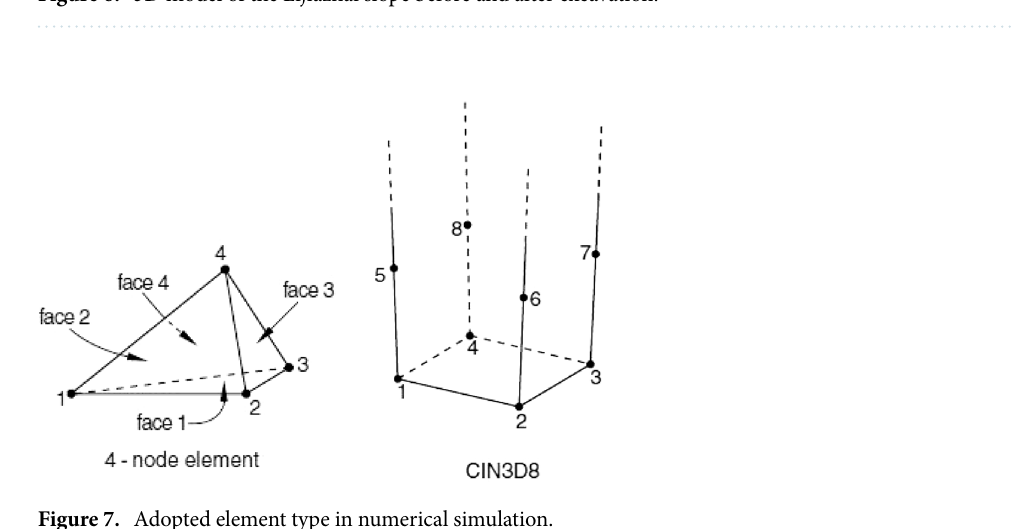
Figure 6. 3D model of the Lijiazhai slope before and after excavation.